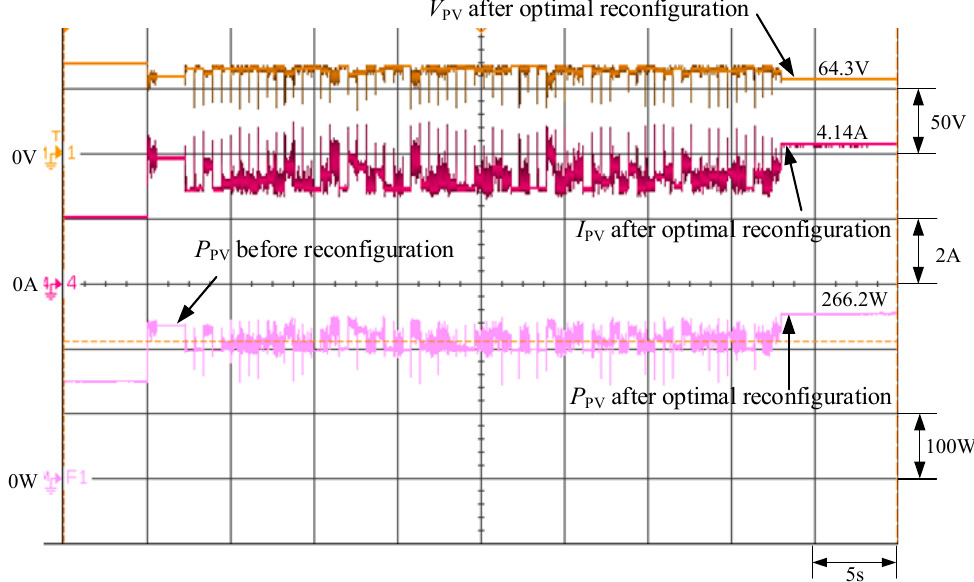
Figure 14. Response to an optimization request in a Case 3 array